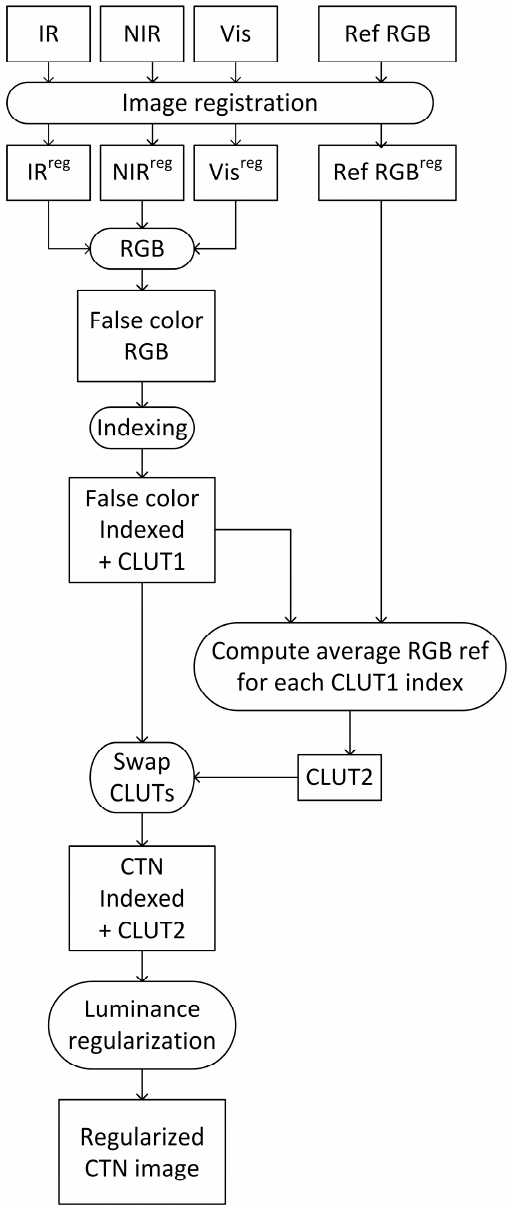
Figure 4. Processing scheme of the CTN sample-based color fusion method.